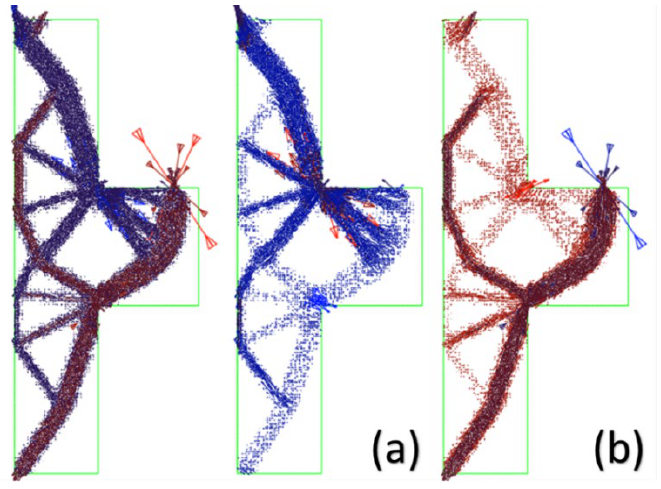
Figure 9. Principal stress trajectories for f = 40% (a: tension; b: compression)